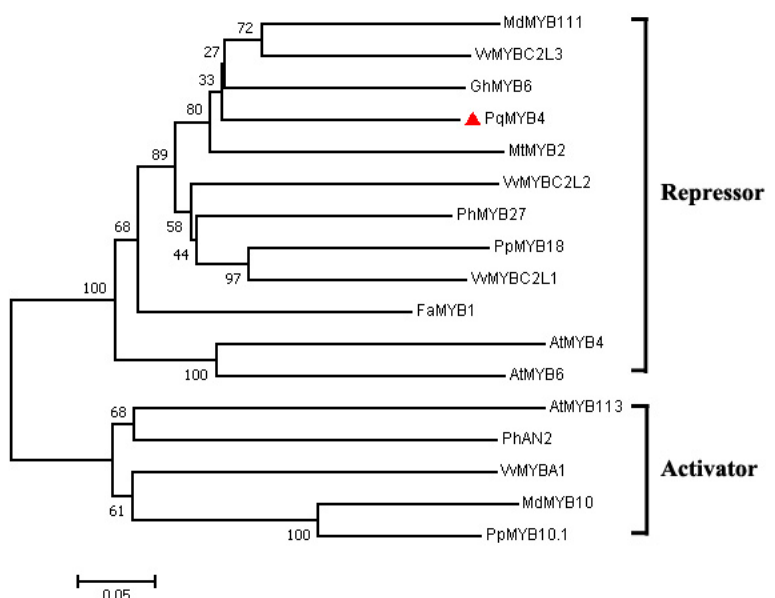
Figure 3. Phylogenetic analysis of PqMYB4 and the MYB proteins known to regulate anthocyanin biosynthesis from other species. PqMYB4 is highlighted with a red triangle. The neighbor-joining method with MEGA software was used to construct the phylogenic tree. Bootstrap values as a percentage of 1000 replicates are indicated at corresponding branch nodes. Scale bar represents the number of amino acid substitutions per site. The GenBank accession numbers are below: Malus domestica , MdMYB111 (ADL36754), MdMYB10 (ABB84754), Vitis vinifera , VvMYBC2-L1 (ABW34394), VvMYBC2-L2 (ACX50288), VvMYBC2-L3 (AIP98385), VvMYBA1 (BAD18977), Gossypium hirsutum